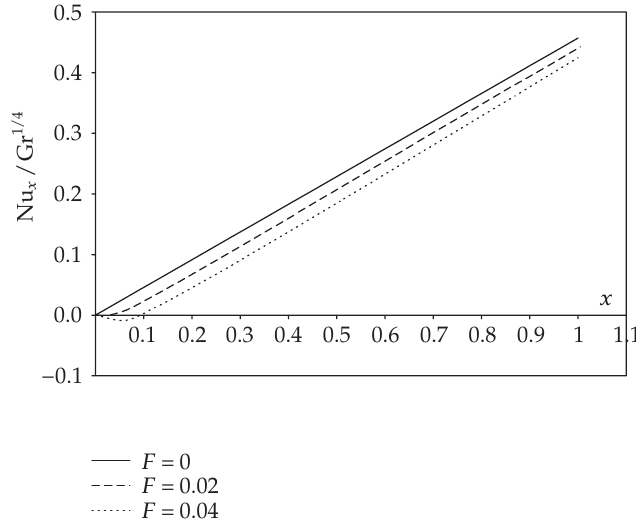
Figure 5.13 . The e ff ect of radiation parameter on local Nusselt num- ber at M = 1, m = 1, and Pr = 0 .